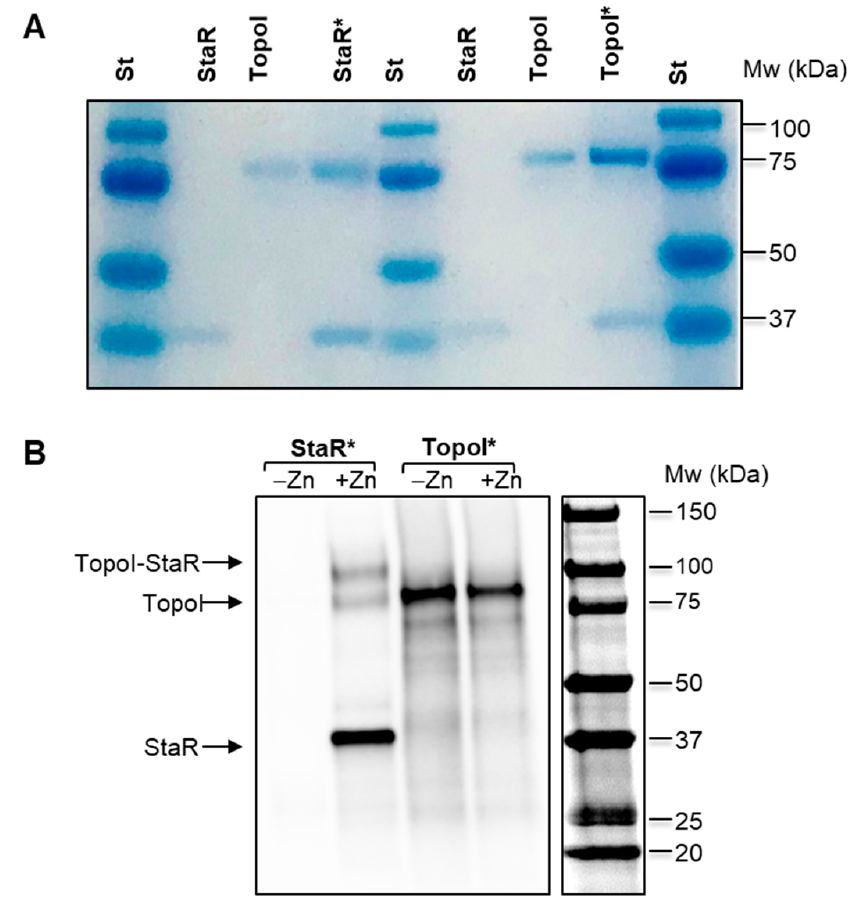
Figure 7. Co-immunoprecipitation of StaR and TopoI. ( A ) In vitro assays. Purified proteins were incubated together in the presence of the antibody against either StaR (StaR*) or TopoI (TopoI*). Samples were treated as described in the Materials and Methods section and run in a 4–20% poly- acrylamide gel, which was stained with Coomassie blue. Purified proteins were loaded as controls. ( B ) In vivo assays. Cultures of ∆ staR P Zn staR were grown either in the absence ( − Zn) or presence (+Zn) of 150 µ M ZnSO 4 to OD 620 nm = 0.4, fixed with formaldehyde and treated as described in the Material and Methods section. The samples were run in a 4–20% polyacrylamide gel and Western blots were performed using antibodies against TopoI (1:500 dilution) and StaR (1:1000 dilution). The expected positions of TopoI and StaR proteins and of the TopoI-StaR complex are